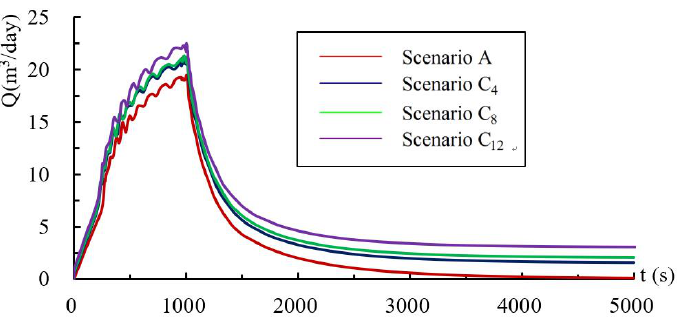
Figure 8. Spring hydrographs with di ff erent injection rate at W4.